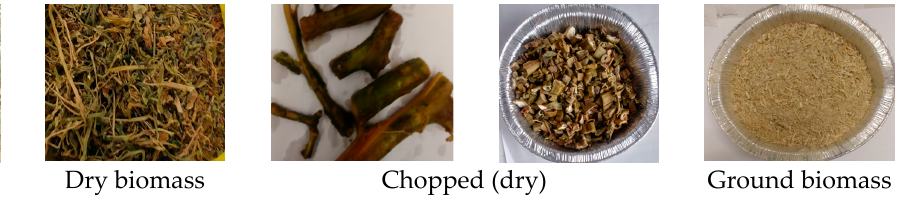
Figure 1. Biomass preparation steps for HTC process.